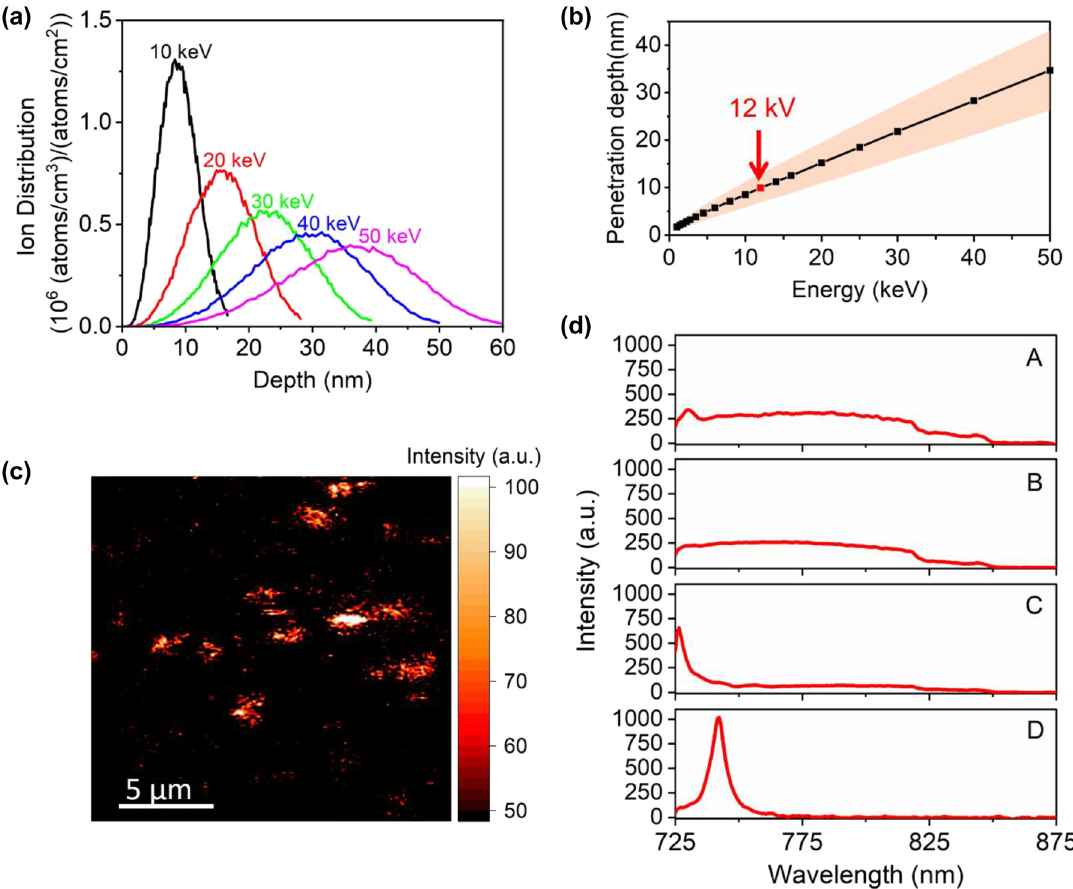
Figure 2: Optimization of the implantation parameters. (a) The implantation depth distribution of Si ions into diamond under different ion implantation energies, obtained from SRIM simulations. (b) The average penetration depth of Si ions as a function of ion implantation energy obtained from SRIM simulations. The yellow shaded area represents standard deviation from average values. The red data point indicates the ion energy (12 keV) used for implantation in this work. (c) A typical photoluminescence (PL) scan on NDs after ion implantation and postannealing, with isolated fluorescing spots. (d) Typical emission spectra of fluorescent spots on ND samples that are implanted with ion fluences of 2 × 10 10 , 1 × 10 12 , 5 × 10 13 , and 1 × 10 15 ions/cm 2 after annealing, noted as sample A, B, C, and D, respectively (as indicated in the graph). All spectra are collected under a 690 nm excitation laser at ∼ 2.6 mW, with the same integration time of 60 s. A long pass filter is used to cut out any fluorescence with wavelengths shorter than 725 nm. This results in the sharp edge formed at ∼ 725 nm in the spectra of sample C. Only the sample implanted at 1 × 10 15 ions/cm 2 shows a sharp emission peak centered around ∼ 740 nm, indicative of SiV